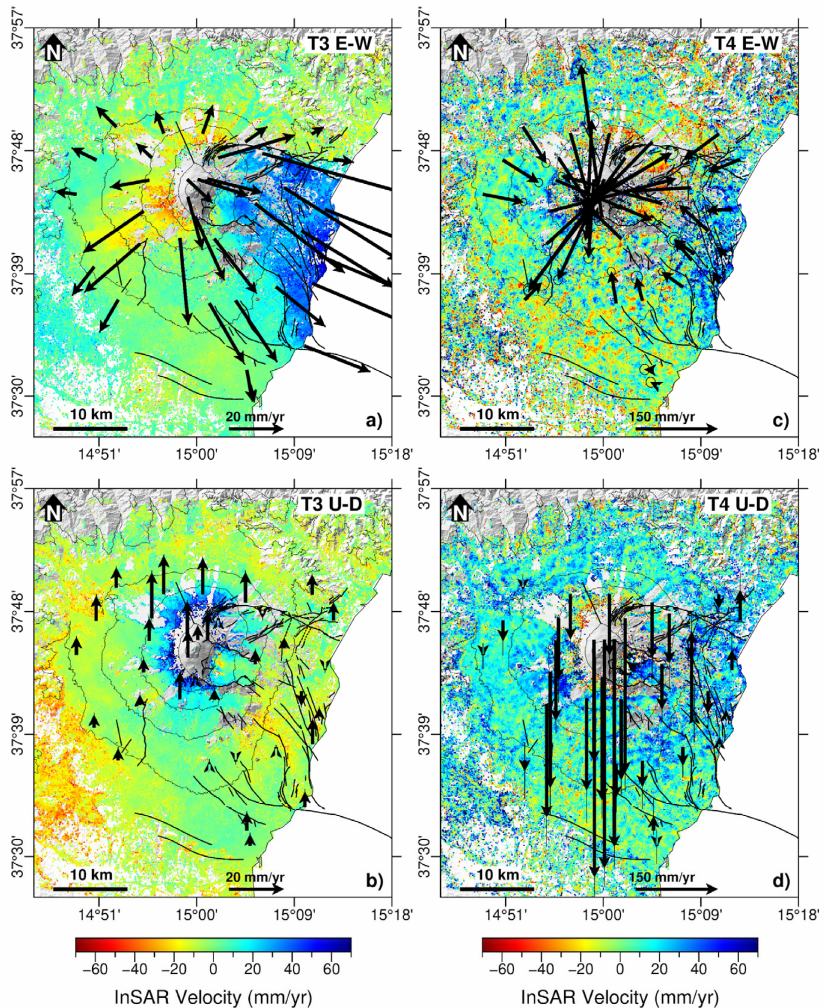
Figure 6. Horizontal (panels a , c ) and vertical (panels b , d ) component velocity maps relative to T3 (2 June 2019–15 February 2021) and T4 (15 February 2021–29 March 2021) time intervals. Positive val- ues (blue colors) represent scatterers eastward in panels ( a , c ); and uplifting in panels ( b , d ). Negative values (red colors) are moving westward in panels ( a , c ), and subsiding in panels ( b , d ). GNSS velocity vectors of the horizontal and vertical components relative to the same time period are reported for each panel as black